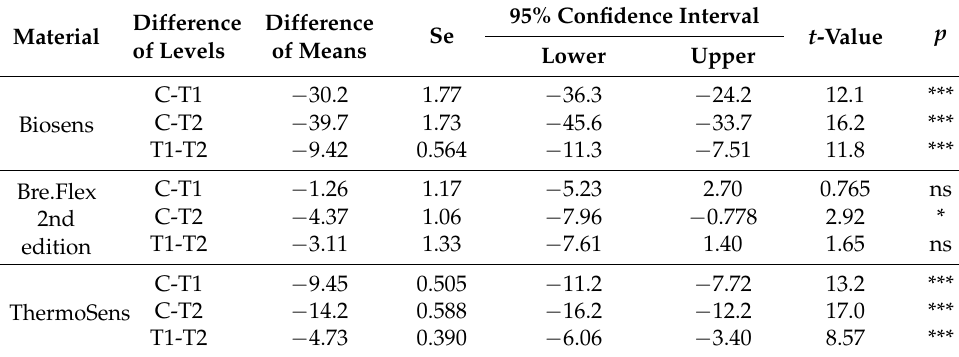
Table 3. Games–Howell post-hoc test for ultimate tensile strength by treatment and storage conditions for the three tested